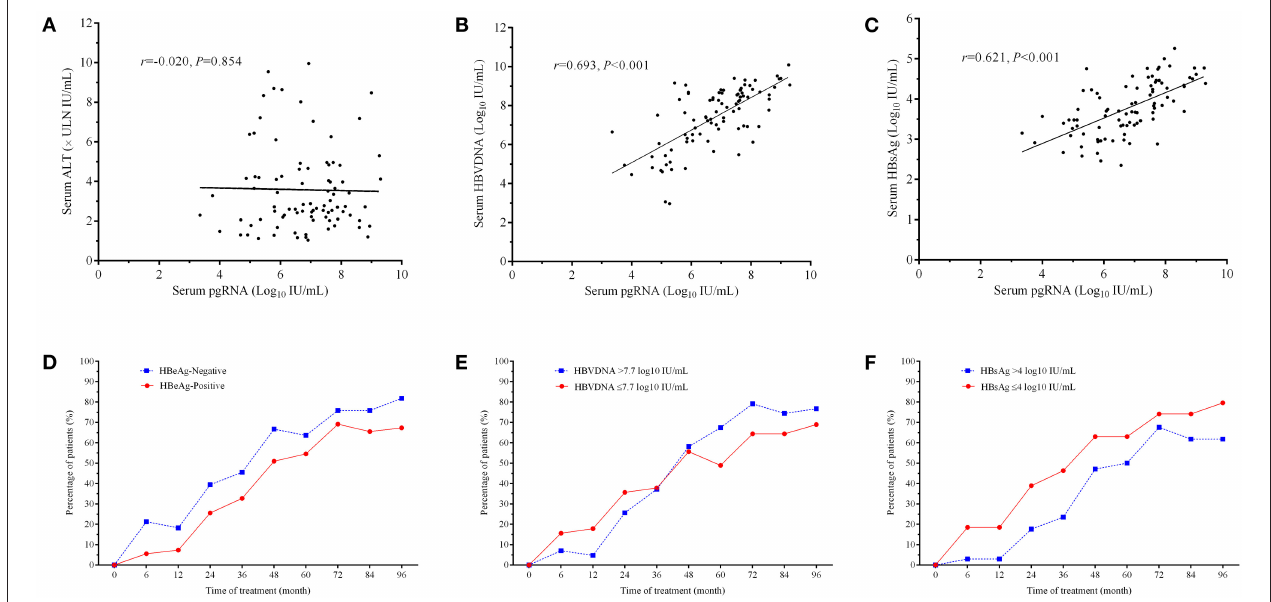
FIGURE 3 | Correlations between serum ALT (A) , HBV DNA (B) , HBsAg levels (C) , and serum pgRNA levels at baseline. Dynamic changes in the percentages of patients with undetectable serum pgRNA during the 96-month NAs treatment in patients of positive- and negative- HBeAg (D) , in patients with either serum HBV DNA